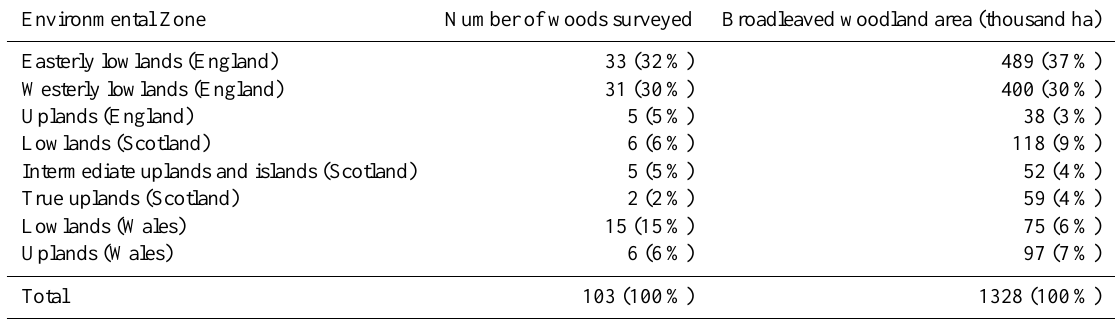
Table 2. Comparisons of numbers of sites surveyed (1971) and broadleaved woodland area (Countryside Survey 2000 data) for different environmental zones (aggregations of land classes) (Carey et al., 2008).